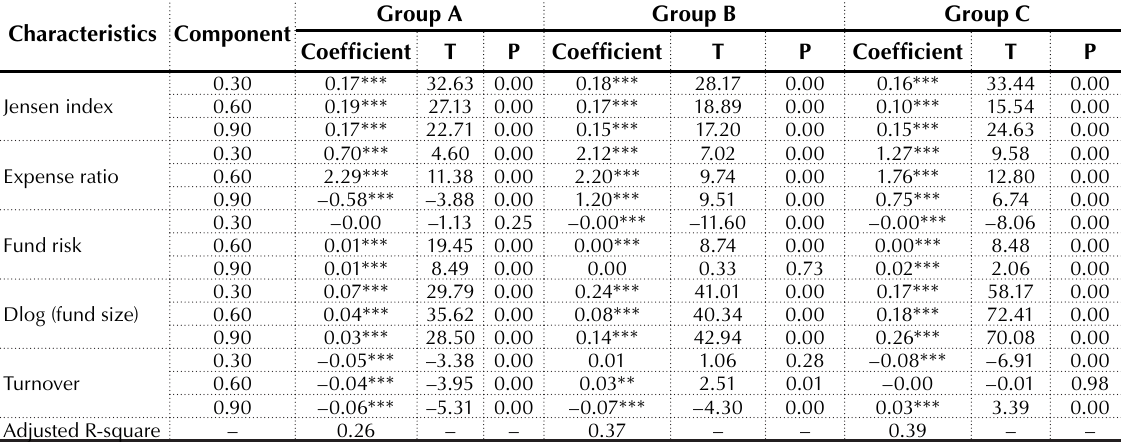
Table 12. Fund outflow, performance and fund characteristics Characteristics